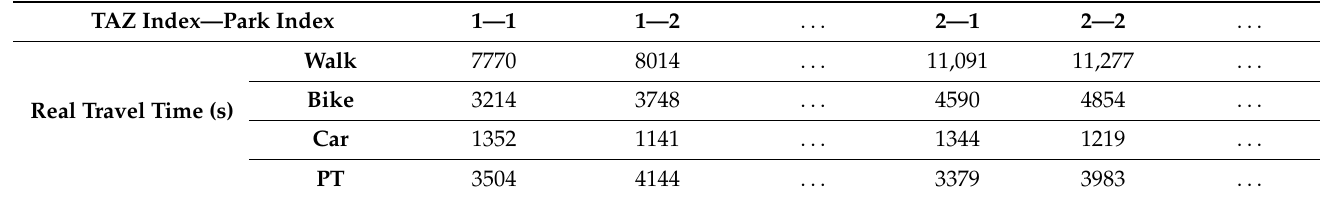
Table 2. Samples of the real travel time